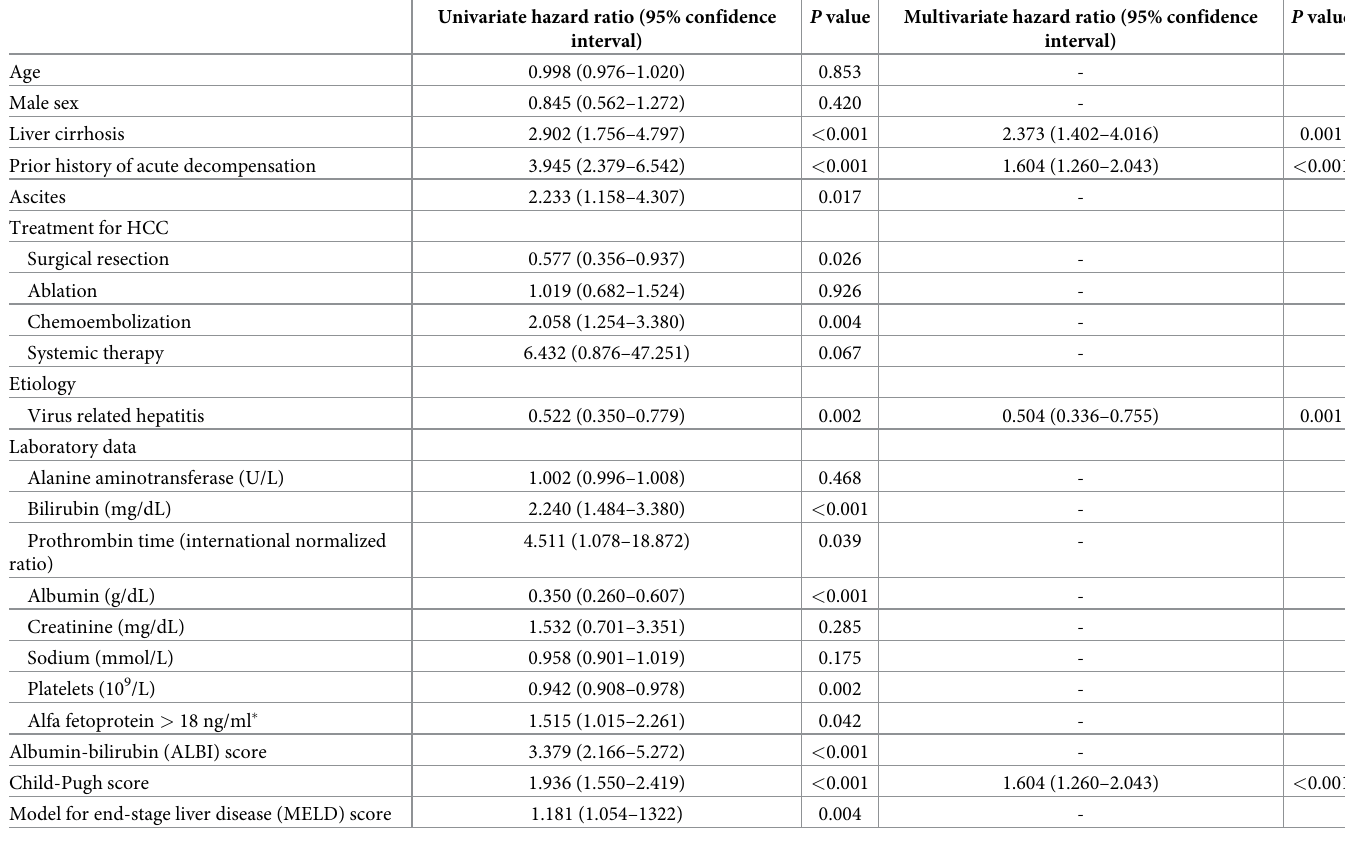
Table 7. Cox regression analyses of predictive factors for the development of acute decompensation in the early-stage